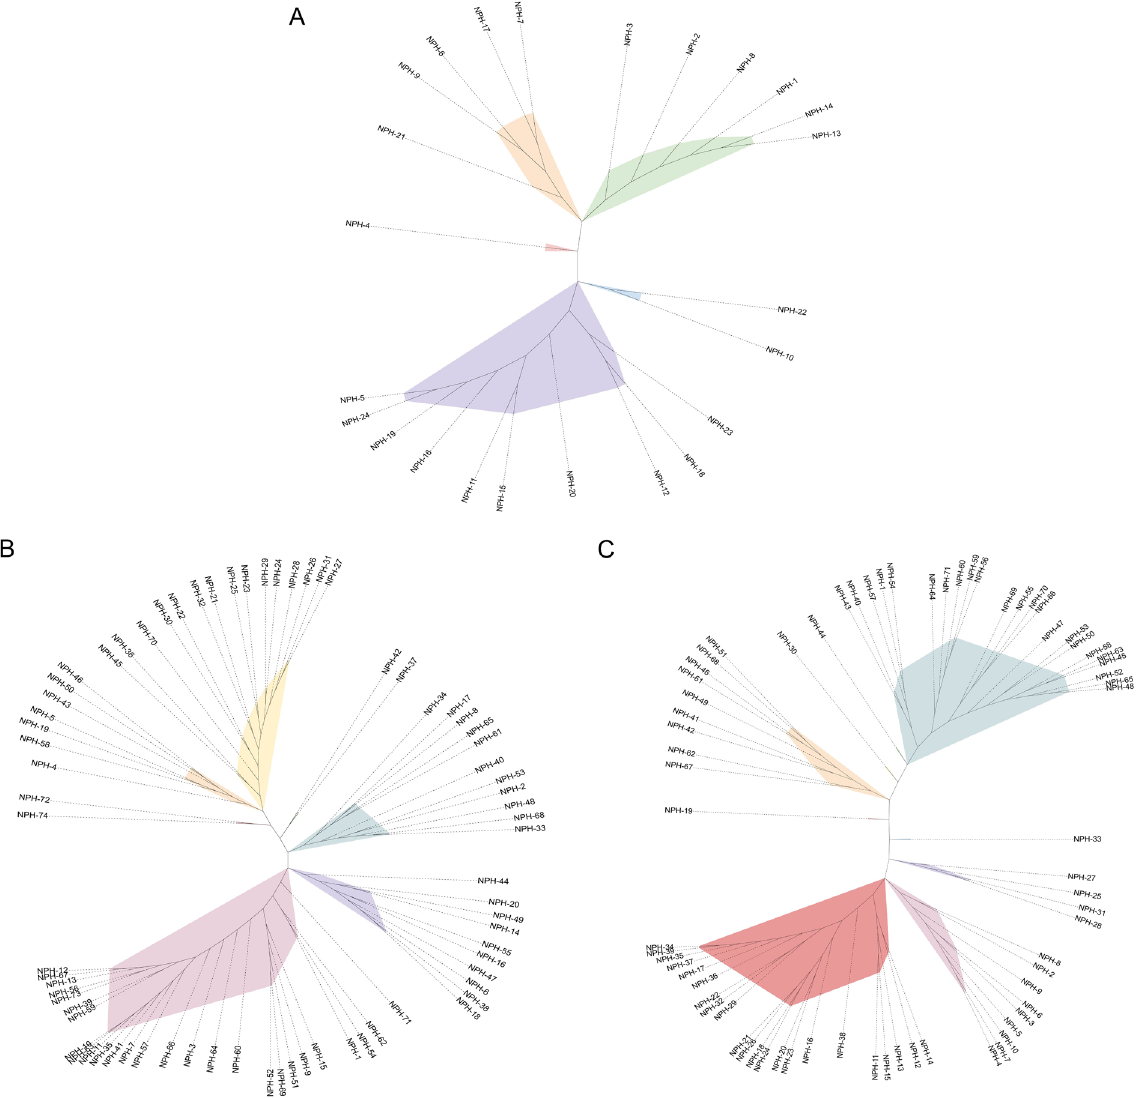
Figure 1. Phylogenetic analysis of phosphorus metabolism AMGs in Napahai plateau wetland, different colors represent different branches. ( A ) Phylogenetic analysis of phoH genes. ( B ) Phylogenetic analysis of phoU genes. ( C ) Phylogenetic analysis of pstS